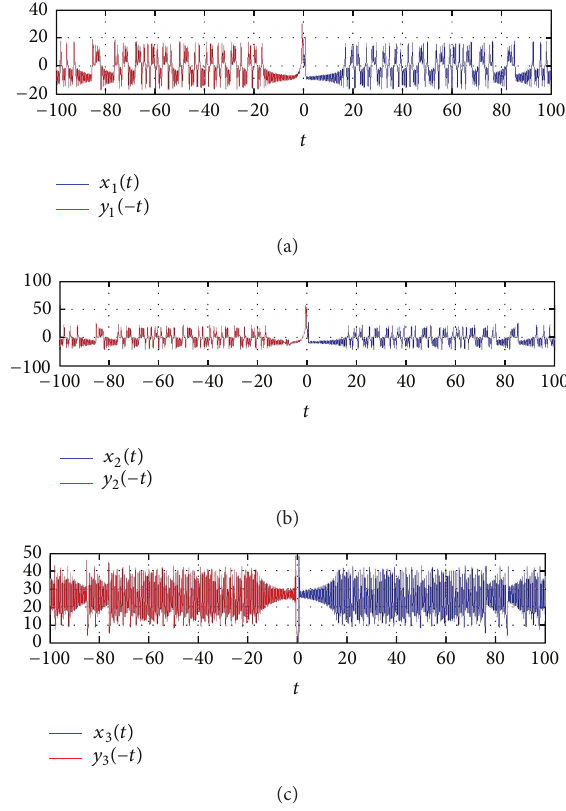
Figure 10: Time histories of states of master and slave chaotic Lorenz systems.